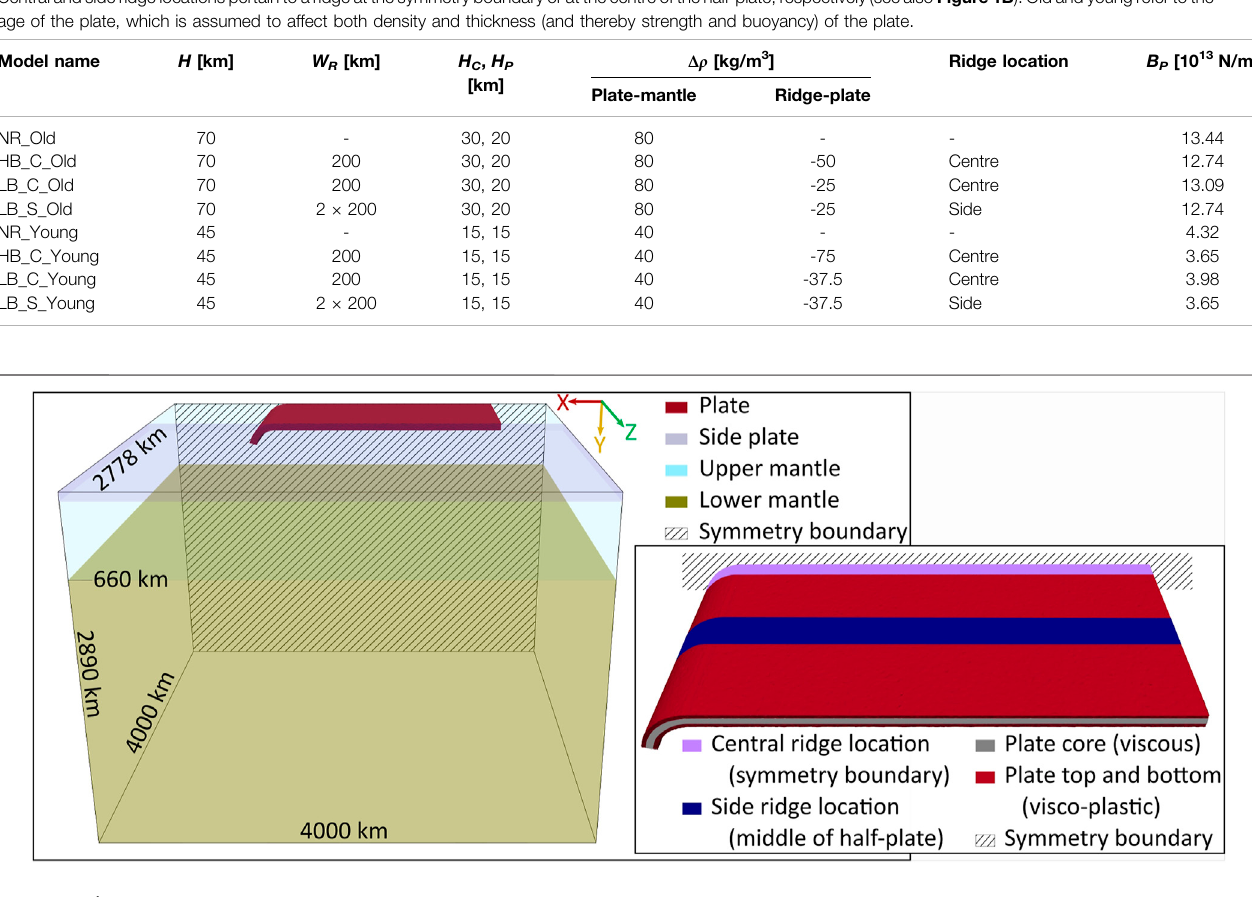
TABLE 1 | Parameters for all model cases. H — plate thickness, W R - ridge width (cases with side ridges effectively contain two symmetrical ridges of this width), H